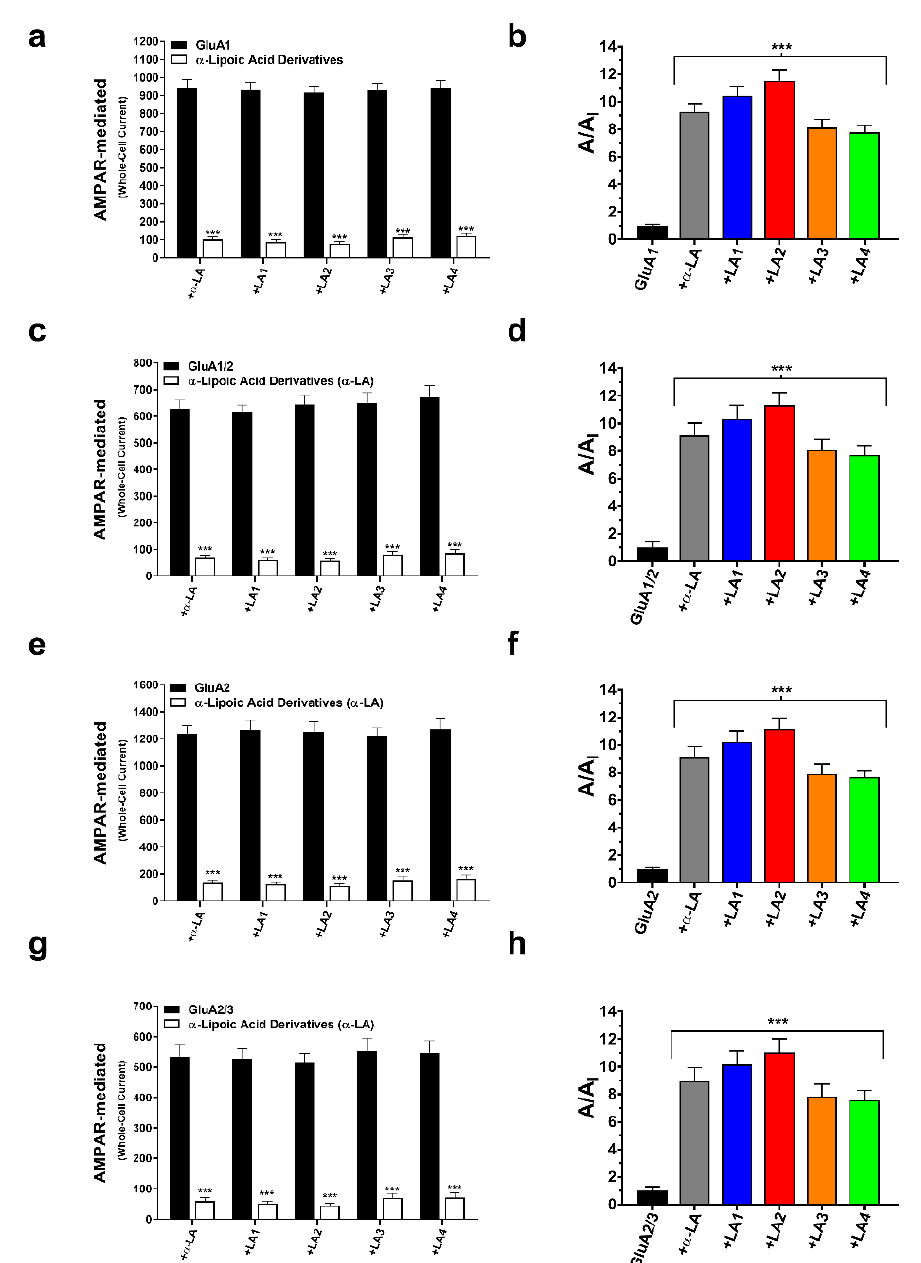
Figure 2. Suppression of AMPA receptor currents by α -LA compounds. Graphs ( a , c , e , g ) present AMPA receptor currents (pA) before and after the administration of α -LA derivatives on GluA1, GluA1/2, GluA2, and GluA2/3 subunits. While ( b , d , f , h ) present the ratio A/A I , where A represents the current caused by 10 mM glutamate alone and A I represents the current induced by glutamate + α -LA (12 µM). The whole-cell current was measured at − 60 mV, pH 7.4, and 22 °C. A one way analysis of variance (ANOVA) was performed for comparison: *** p < 0.001; ns, not significant. Ten cells were investigated for each LA compound. All values are shown as mean SEM.